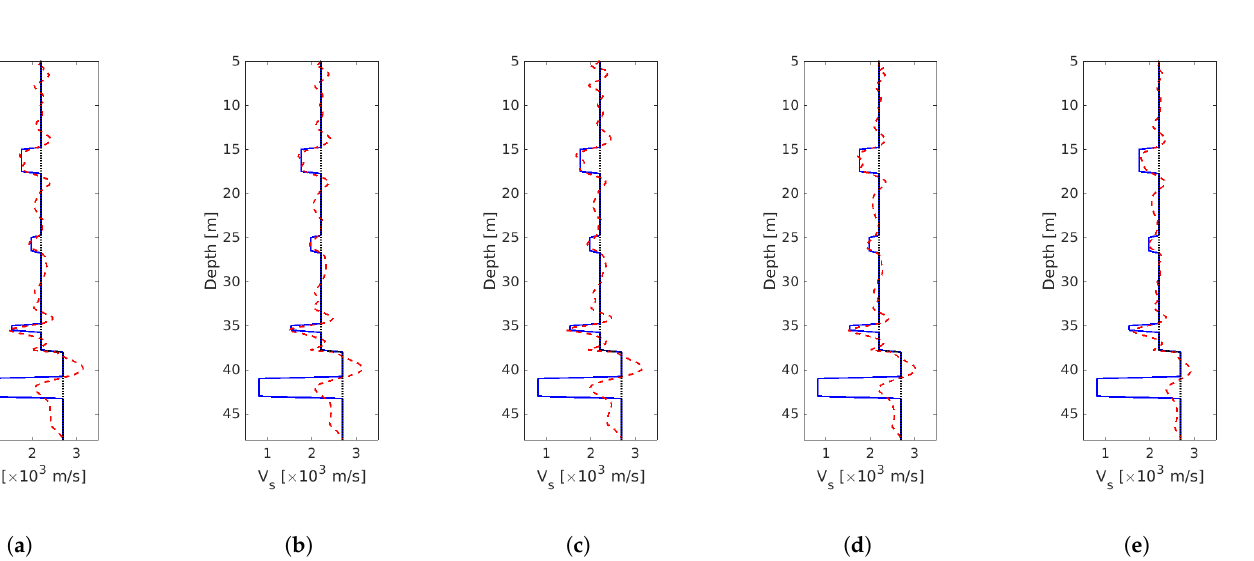
Figure 13. Profile cut for V s through the dam in regions of reconstructed anomalies for different noise levels showing a comparison between the true model (—), FWI model (- -) and the initial model ( · · ·